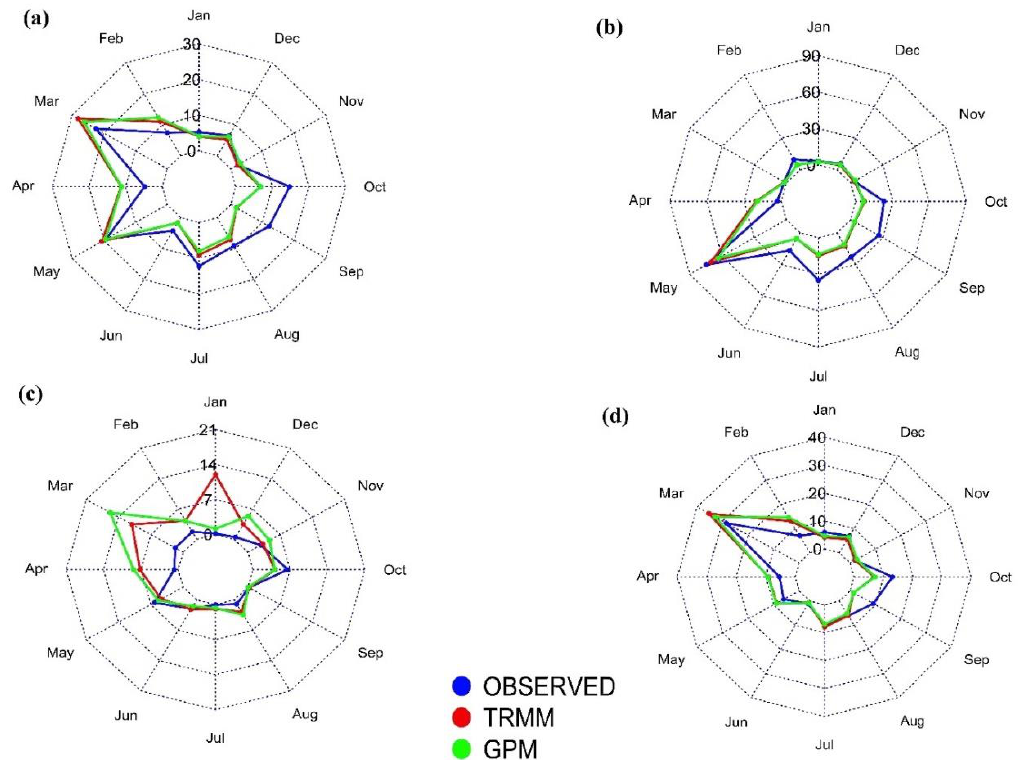
Figure 5. Regional monthly averages of precipitation estimates from gauged and satellite products for ( a ) entire country, ( b ) Dhofar, ( c ) Interior, and ( d ) Northern region for 2016 – 2018. OBSERVED, Tropical Rainfall Measuring Mission (TRMM), and Global Precipitation Measurement (GPM) are in blue, red, and green, respectively. Months are the axes (anti-clockwise), and the values on the axes are monthly precipitation (mm/month).